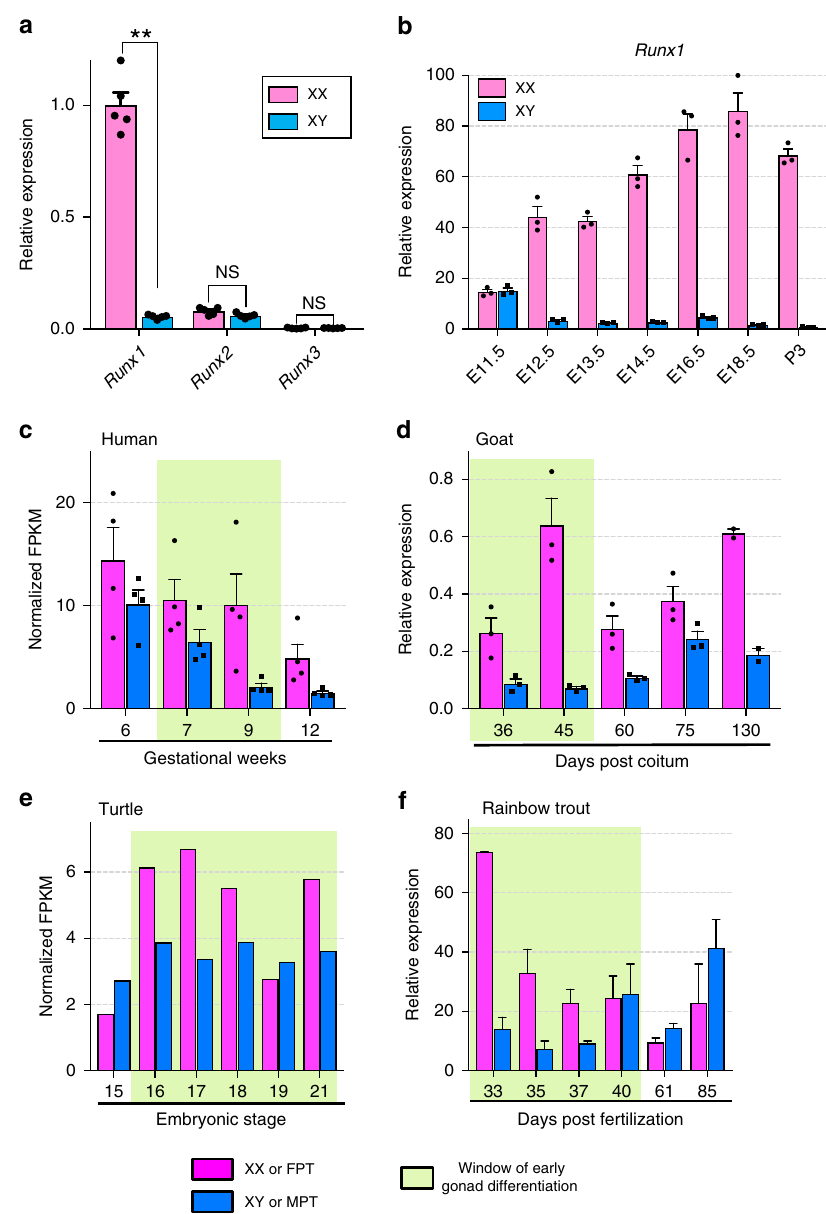
Fig. 1 RUNX1 expression during gonadal differentiation in various vertebrates. a Expression of Runx1 , Runx2 , and Runx3 mRNAs in XX and XY gonads of E14.5 mouse embryos ( n = 5/sex). Values are presented as mean ± SEM; non-parametric t -test, ** p < 0.01; NS, not signi fi cant. b Expression time course of Runx1 mRNA in mouse XX and XY gonads during gonadal differentiation ( n = 3/stage). Values are presented as mean ± SEM. c – f Time course of RUNX1 mRNA expression in four other vertebrate species, human, goat, red-eared slider turtle, and rainbow trout during gonad differentiation. Values are presented as mean ± SEM. For the turtle, pink and blue bars represent gonads at female-promoting temperature (FPT) of 31 °C and at male-promoting temperature (MPT) of 26 °C, respectively 64 . RUNX1 expression was analyzed by RNA-seq in human and red-eared slider turtle 64 , and by qPCR in goat and rainbow trout. Green highlighted areas represent the window of early gonadal differentiation. Source data are provided as a Source Data fi